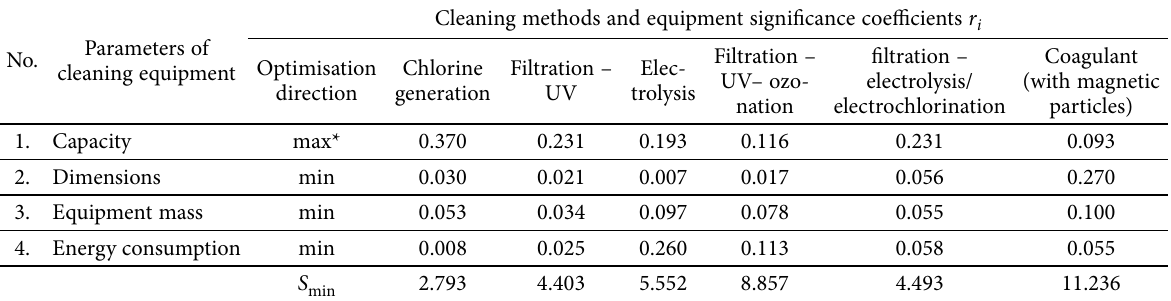
Table 5. The ballast water treatment methods and the assessment of